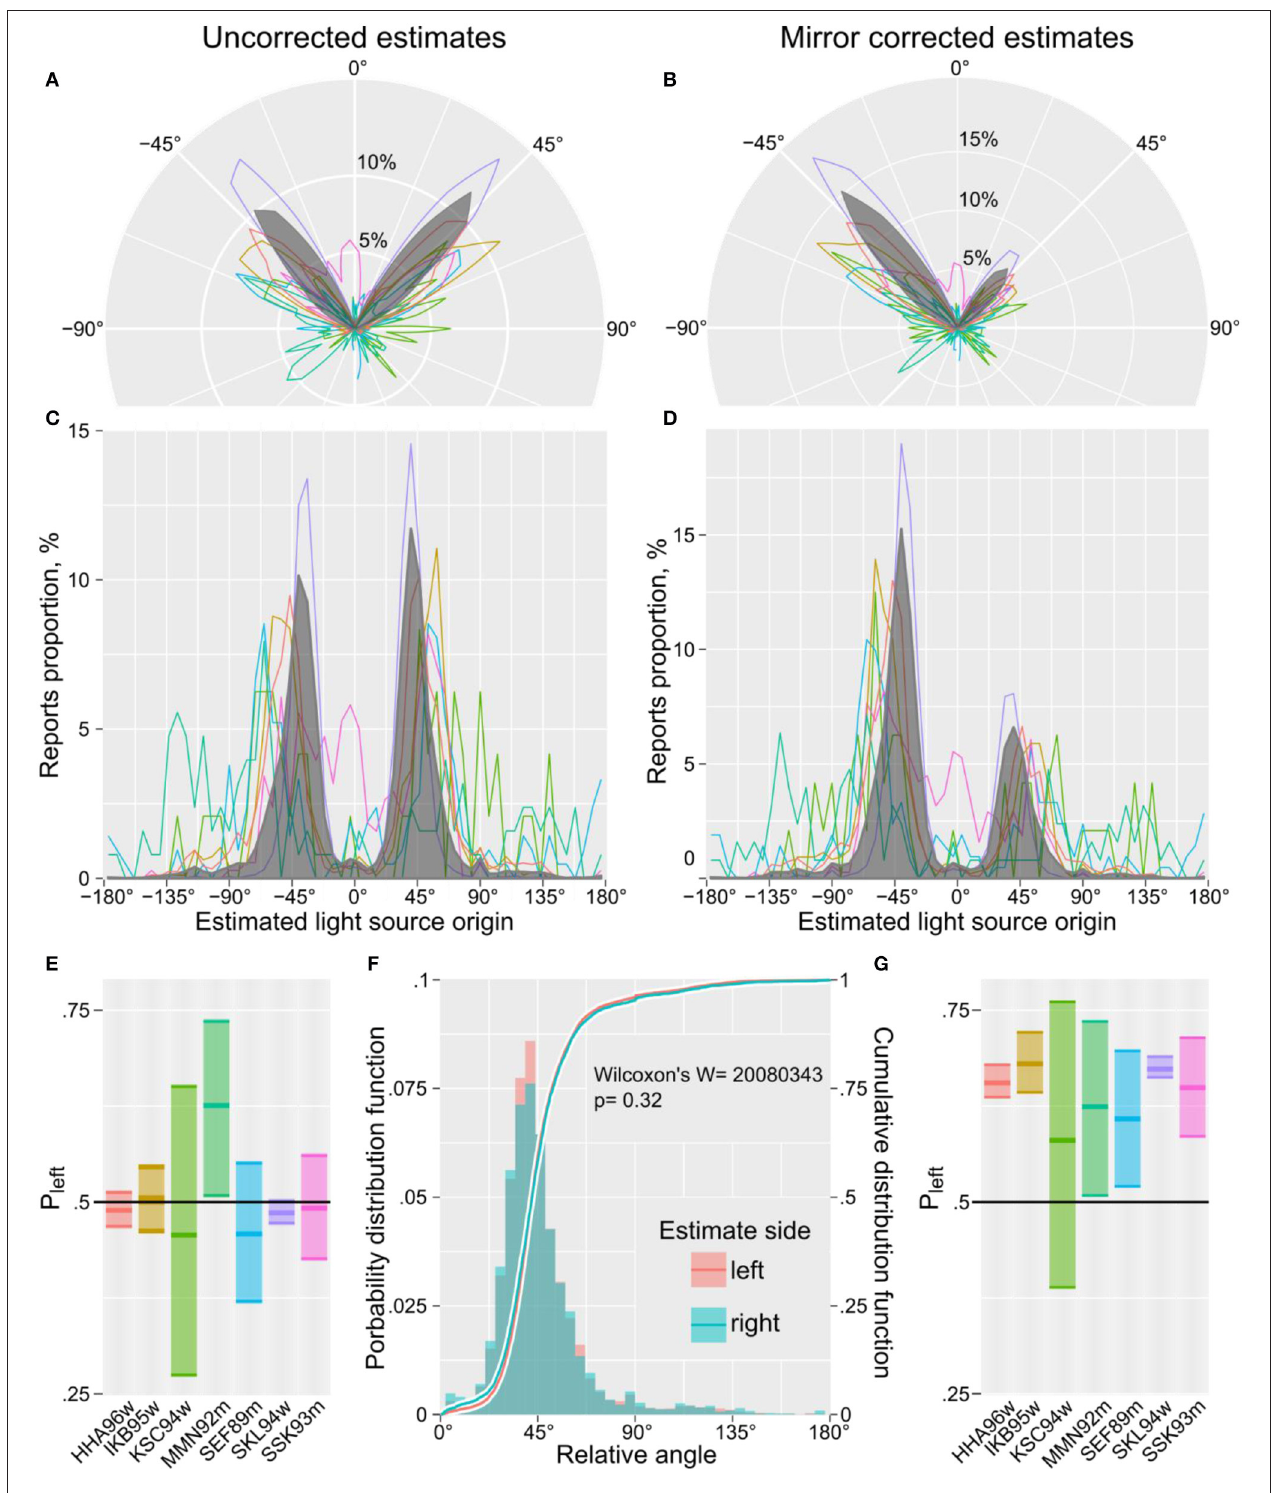
FIGURE 3 | The estimated angles of illumination for (A,C) the raw uncorrected estimates and (B,D) the mirror corrected estimates. Plotting conventions: 0 ◦ corresponds to the light source being positioned directly above the paintings. Solid lines depict individual observers, gray area depicts the overall group responses. (E,G) Proportion of estimates left off the vertical ( P left , mean and 99% binomial confidence interval). (F) Distribution of the relative angle for light source estimates with light originating on the left and right side.